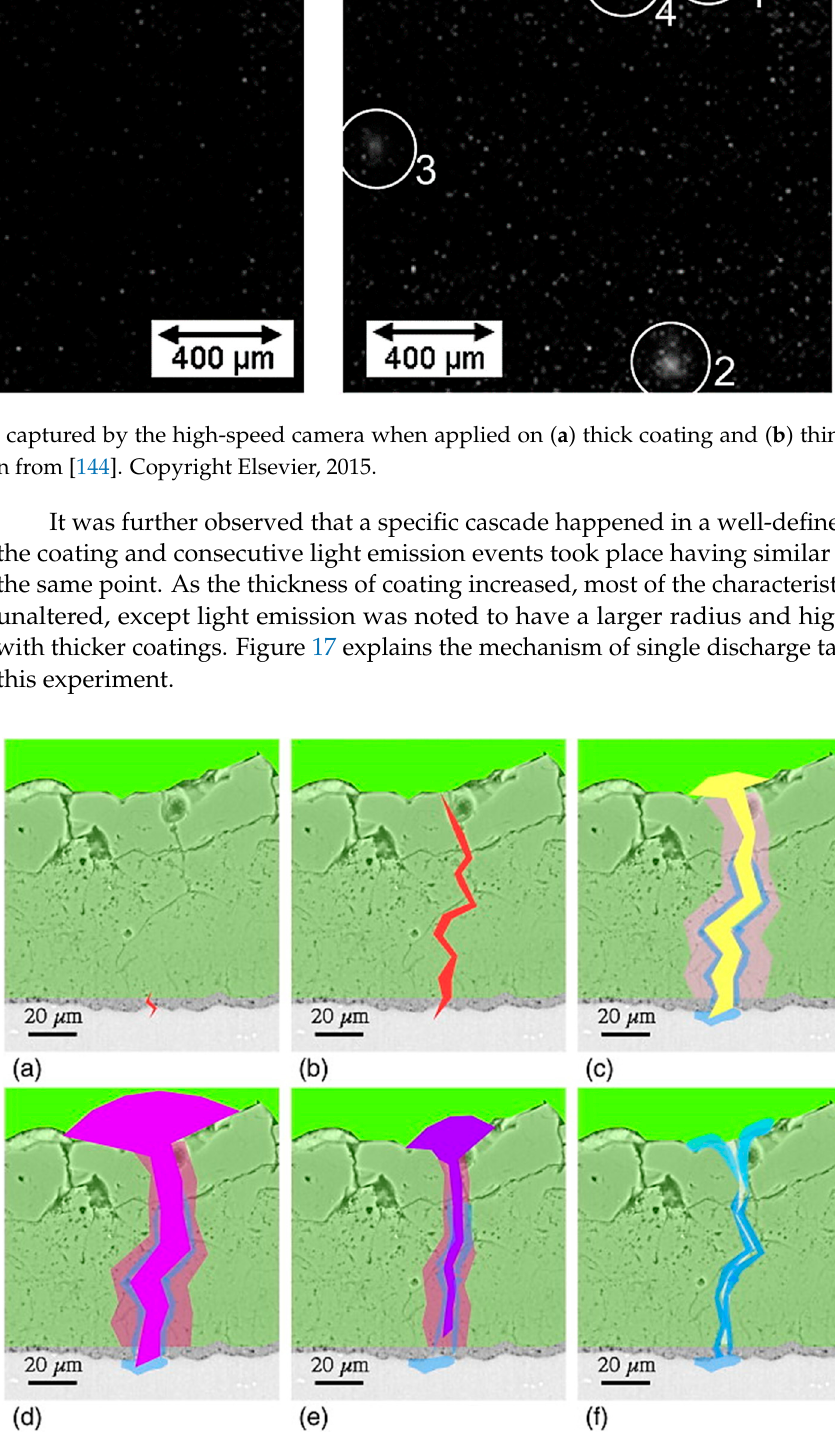
Figure 17. Description of events taking place during single discharge: ( a ) break down at beginning, ( b ) formation of plasma channel through coating, ( c ) beginning of bubble growth and generation of oxide, ( d ) enlargement of bubble and heating of adjacent region, ( e ) decrease of bubble area due to cooling, and ( f ) last stage signifying quenching and removal of liquefied oxide from discharge channel. Reproduced with permission from [144]. Copyright Elsevier, 2015.